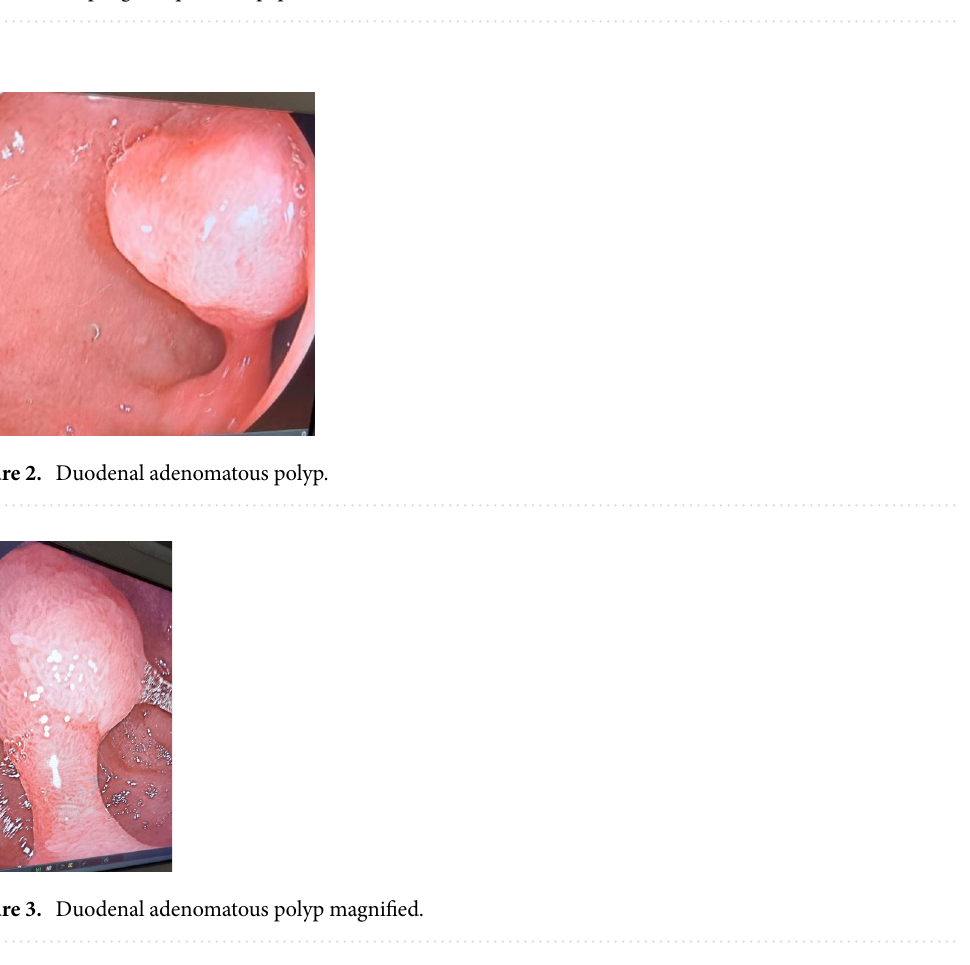
Figure 1. Esophageal squamous papilloma.